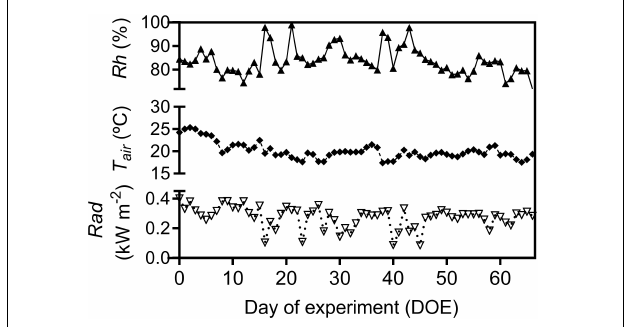
FIGURE 1 | Daily average of relative air humidity ( Rh ), air temperature ( T air ) and average diurnal total solar radiation ( Rad ), during the experimental period.